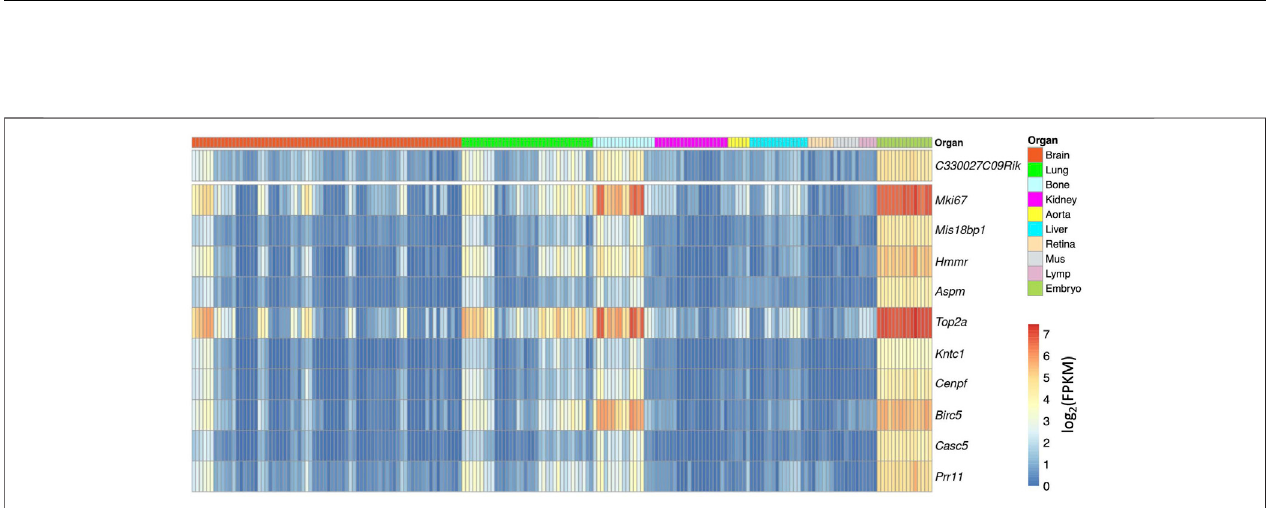
FIGURE4| Heatmapoverviewofthetopcorrelatedgenesto C330027C09Ri k.EachcolumnshowsoneRNAseqsample,anditsorganoriginiscoloredonthetop of the heatmap. The top 10 correlated genes are visualized. The heatmap color shows the expression level in each sample (log2 scaled FPKM) (high-resolution image is available in the ECO online